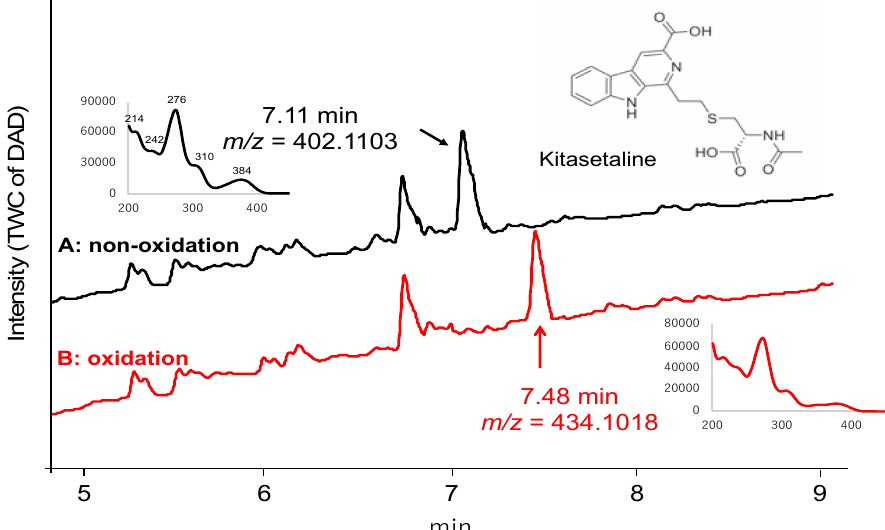
Figure 2. LC / MS chromatograms of kitasetaline-containing broth for the ( A ) control (non-oxidized) and ( B ) Mo-catalyzed samples. The physicochemical properties of kitasetaline are also shown. Mass-to-charge ratios ( m / z ) are indicated as [M + H] + .